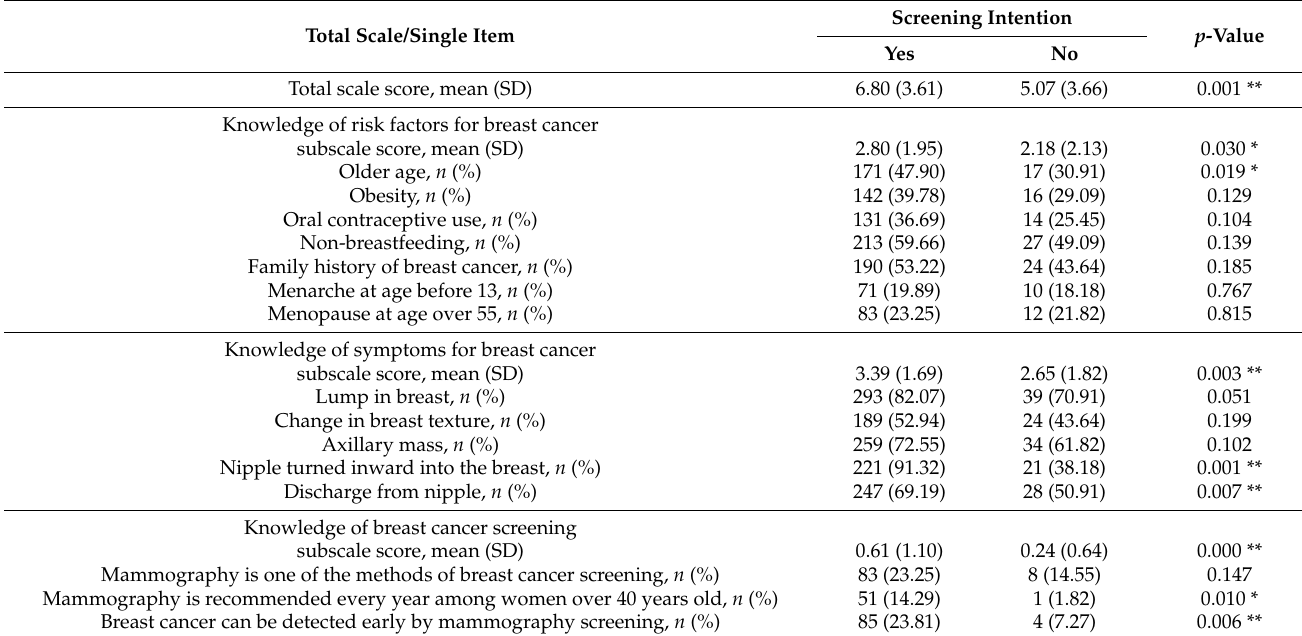
Table 2. Comparison of knowledge about breast cancer among urban women with and without screening intention in Wuhan, China.